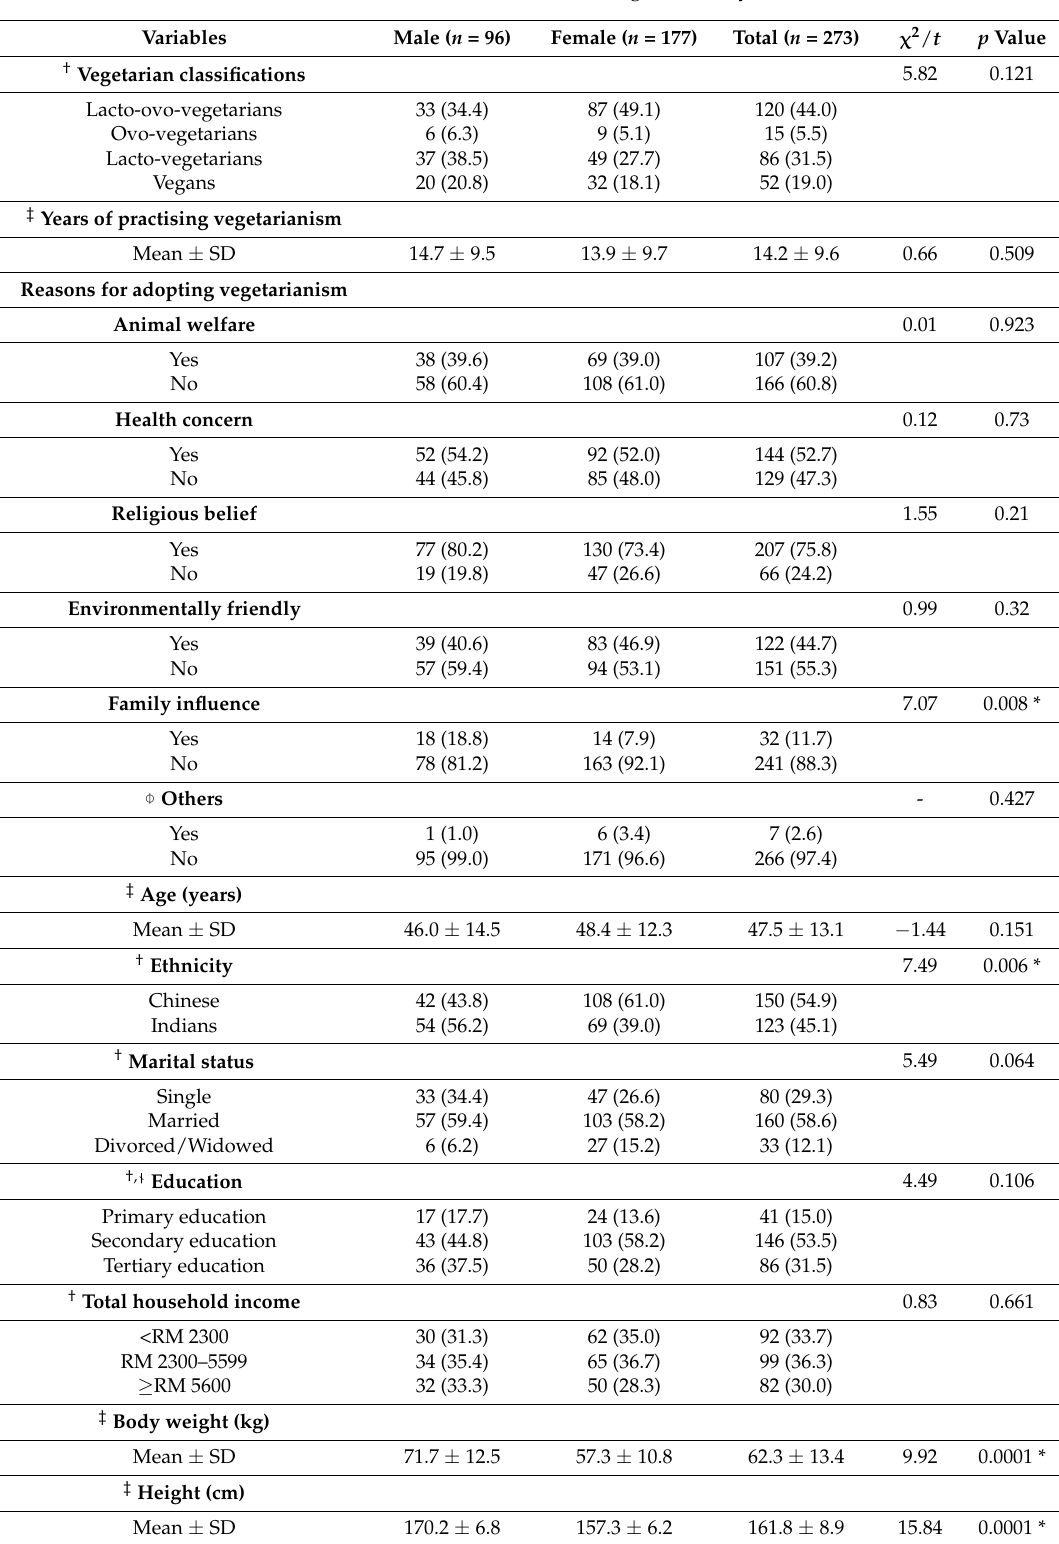
Table 1. General characteristics of vegetarians by